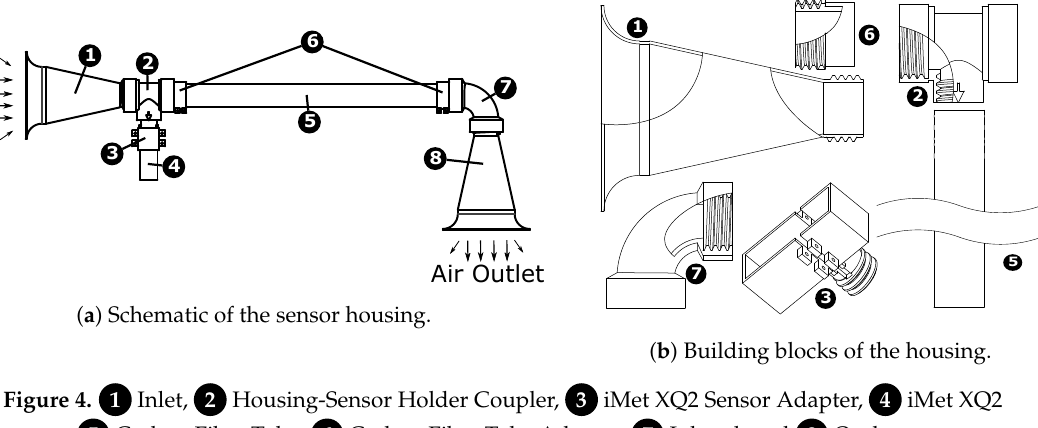
Figure 4. 1 Inlet, 2 Housing-Sensor Holder Coupler, 3 iMet XQ2 Sensor Adapter, 4 iMet XQ2 sensor, 5 Carbon Fiber Tube, 6 Carbon Fiber Tube Adapter, 7 L-bend, and 8